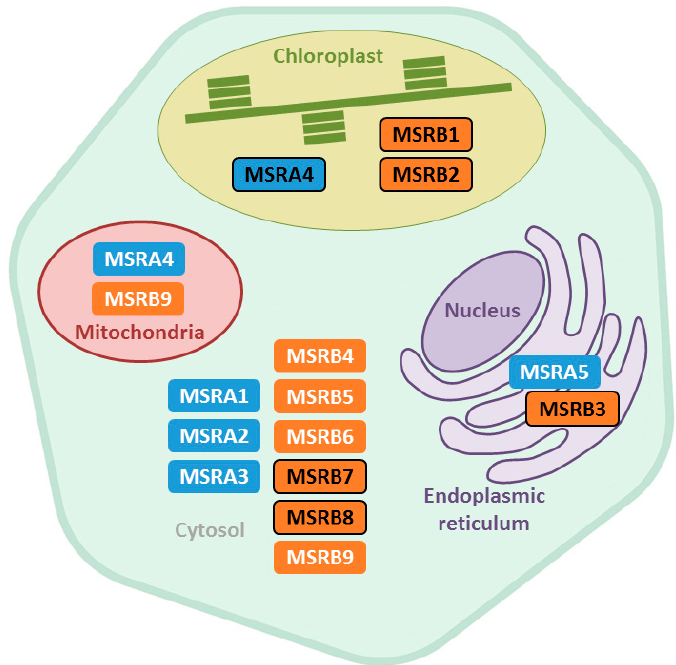
Figure 2. Subcellular localization of MSRs in Arabidopsis thaliana . Localization of MSRA4, MSRB1, and MSRB2 in plastid, of MSRB3 in endoplasmic reticulum and of MSRB7 and MSRB8 was proven experimentally [49–52]. These isoforms appear in black. For other isoforms (in white), the localization is based on predictions from sequence analysis or on proteomic analyses [63–65].